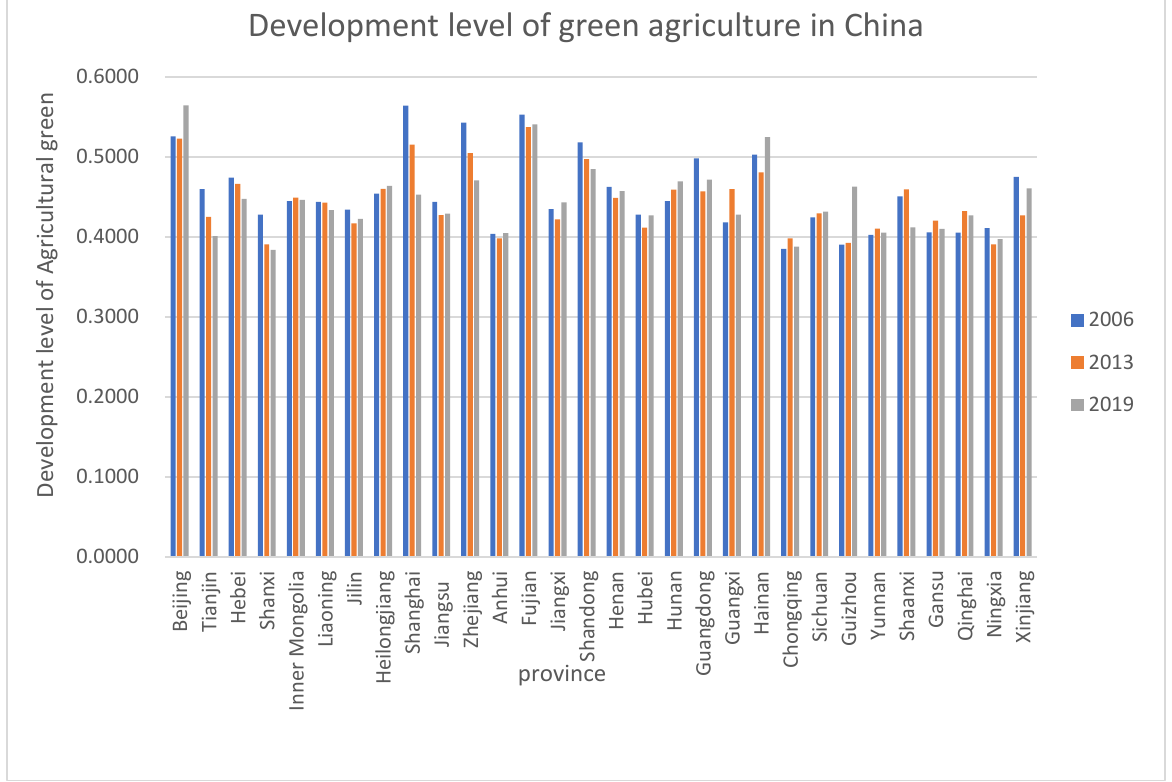
Figure 3. Development level of green agriculture in China.